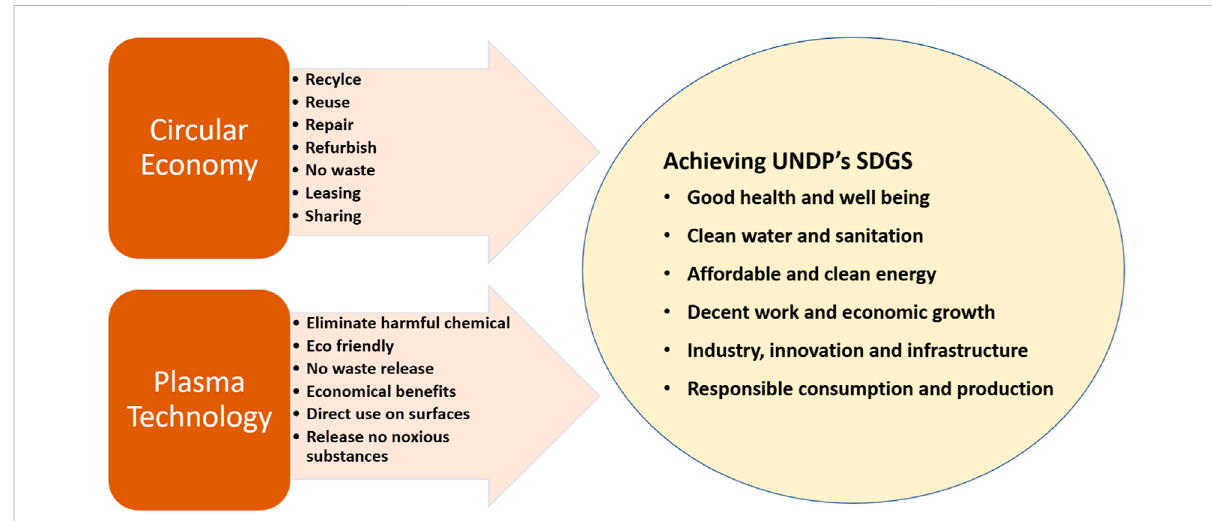
FIGURE 5 The relationship between the use of plasma technology and circular economy in achieving the UNDP ’ s